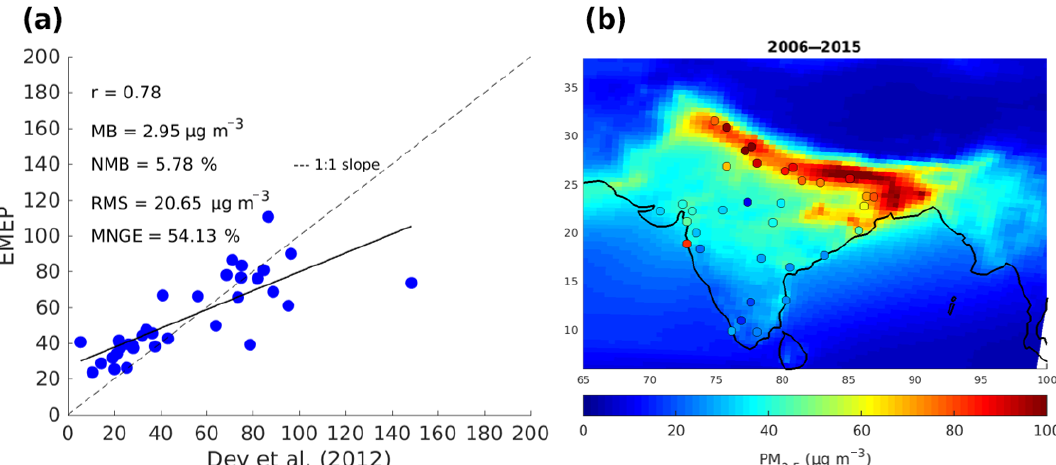
Figure 5. (a) Scatterplot between the surface PM 2 . 5 concentrations from EMEP (averaged over the period of simulation) and the concen- trations listed in Dey et al. (2012) in µgm − 3 . The correlation coefficient ( r ), the mean bias (MB), the normalized mean bias (NMB), the root mean square (RMS) error and the mean normalized gross error (MNGE) are provided. (b) Distribution of the mean surface PM 2 . 5 concentrations for the period 2006–2015 (reference scenario). The measurements from Dey et al. (2012) are superimposed on the map and represented by coloured dots.